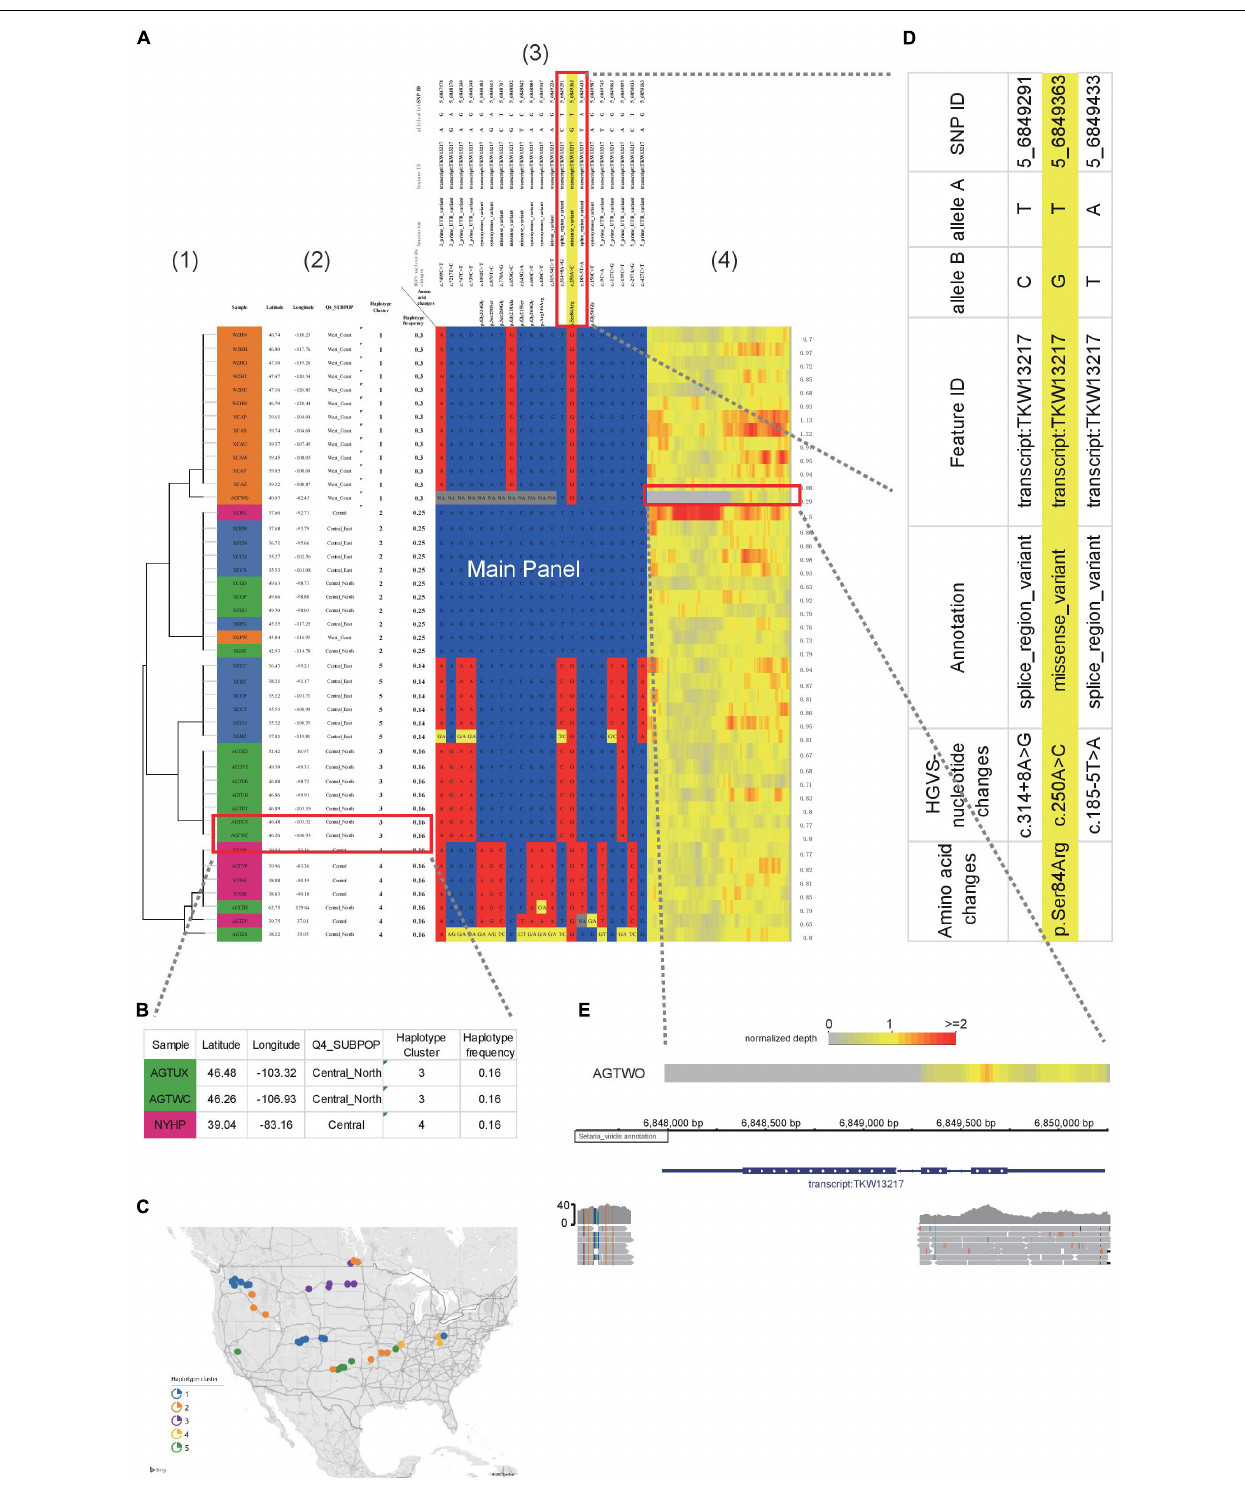
FIGURE 2 | Example of HAPPE on the display of S. viridis gene Sevir.5G085400. (A) Haplotypes of the S. viridis gene Sevir.5G085400, which shows additional information, including (1) a tree, (2) descriptions of samples, (3) annotations of SNPs and (4) a heatmap of read depth. (B) Magnified view of Panel 2 showing the descriptions of the samples. (C) A map generated using the geographical coordinates shown in the table. (D) Zoomed-in view of Panel 3 showing the annotations of SNPs. (E) A deletion event shown by the heatmap of read depth in Panel 3, which was further confirmed in a genome browser. More details can be found in Supplementary Tables 1–3